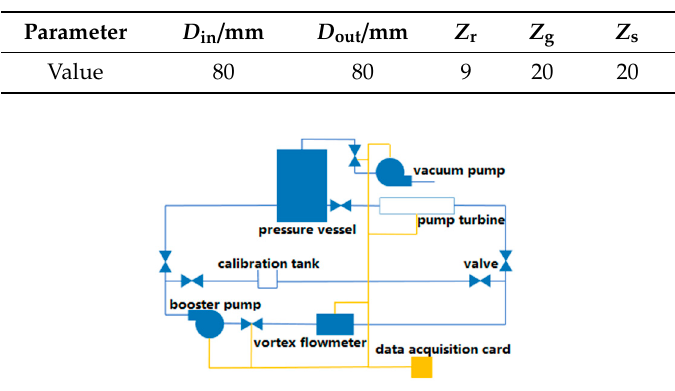
Figure 2. Schematic diagram of the experiment bench. Table 1. Main geometric parameters of the pump turbine in pump mode.